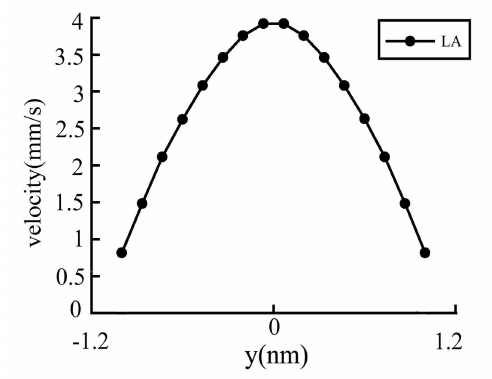
Figure 3. Poiseuille flow simulations of case 1 (low flow velocity simulations). is the result of this paper (LA